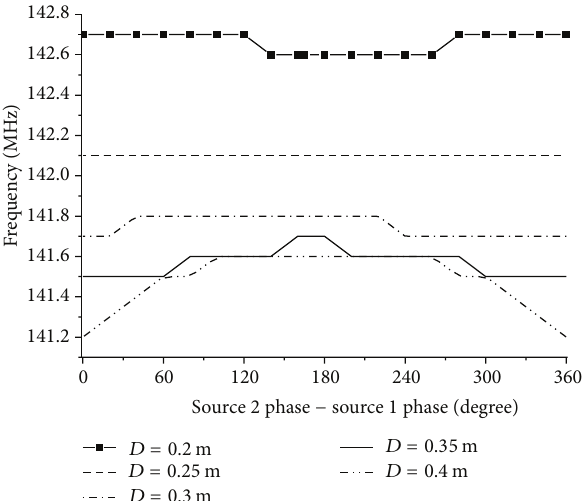
Figure 11: Operating frequency of PTE mat against phase difference for different 𝐷 .